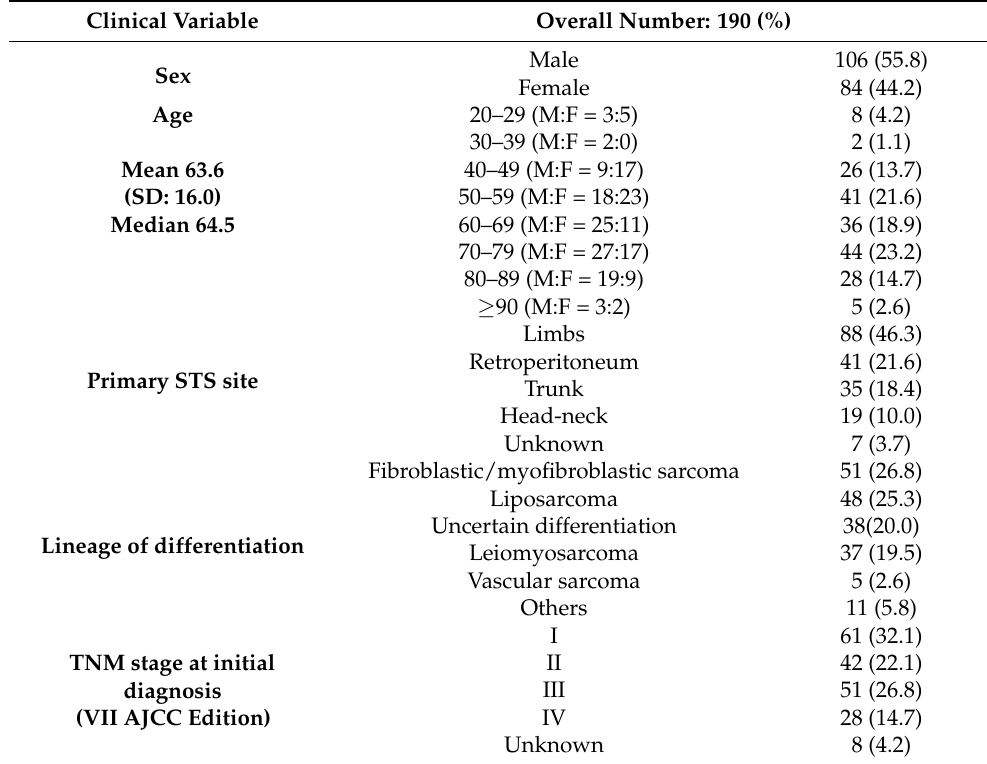
Table 1. Demographics and clinical variables of the